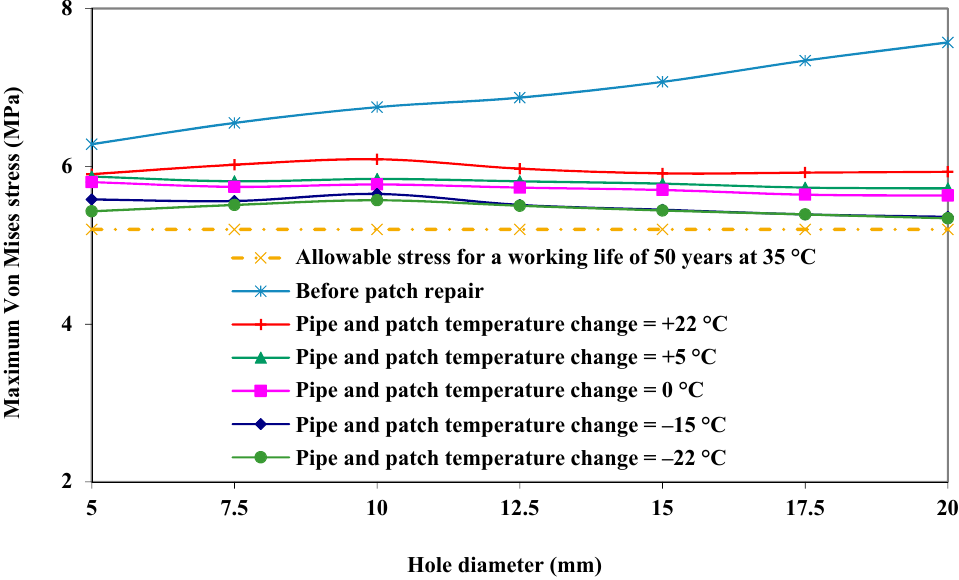
Figure 15. Maximum Von Mises stress variations in the buried pipe for various sizes of circular hole defects repaired by square partial patch (the simultaneous effect of soil load, internal pressure, vehicle wheel load and temperature variations).